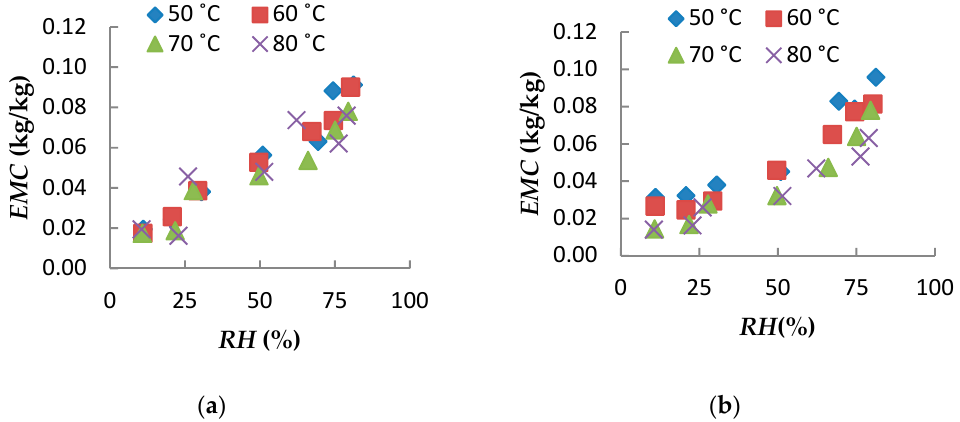
Figure 8. Desorption isotherm of whole palm kernel ( a ) and ground palm kernel ( b ).